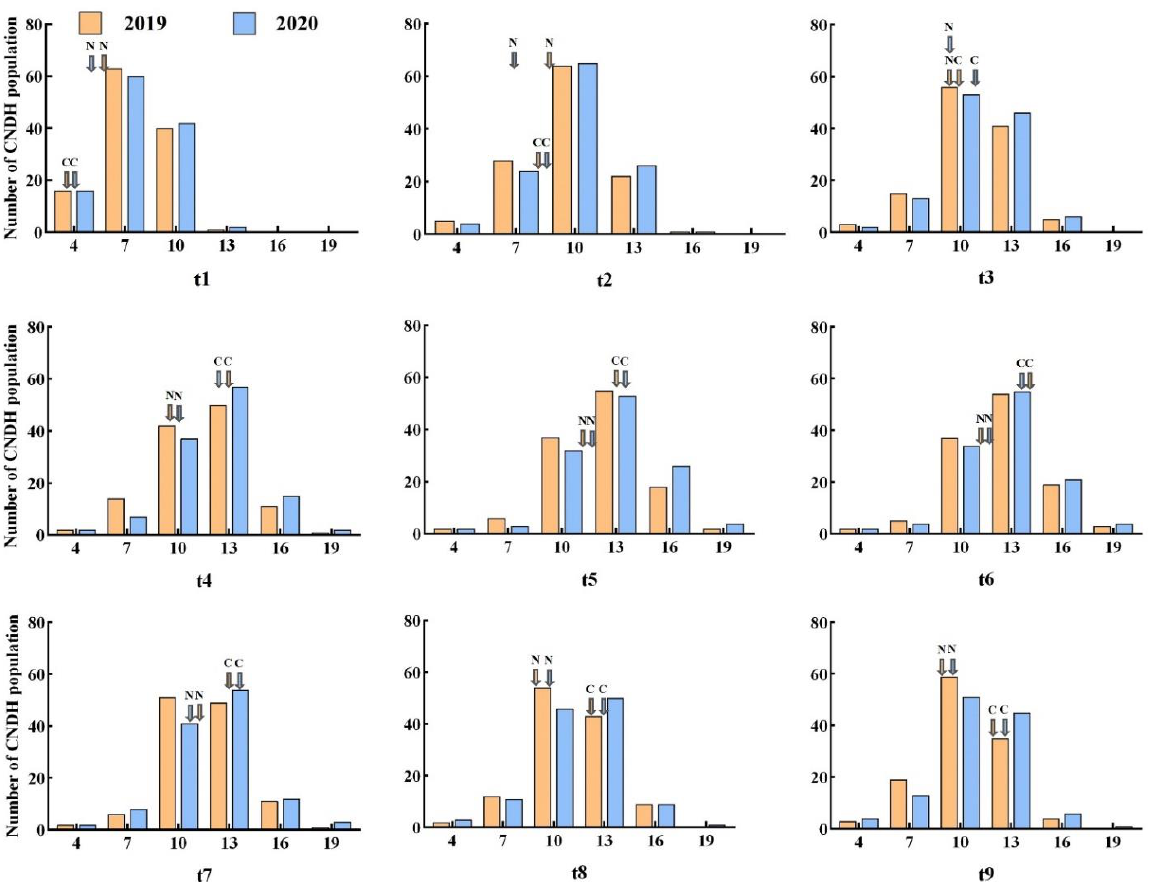
Figure 2. Tiller number averaged over the CNDH population at different growth stages. t1 to t9 refers to the tiller number at each measuring stage; the measurement intervals were set as 7 days between stages. (C) Cheongcheong; (N) Nagdong.